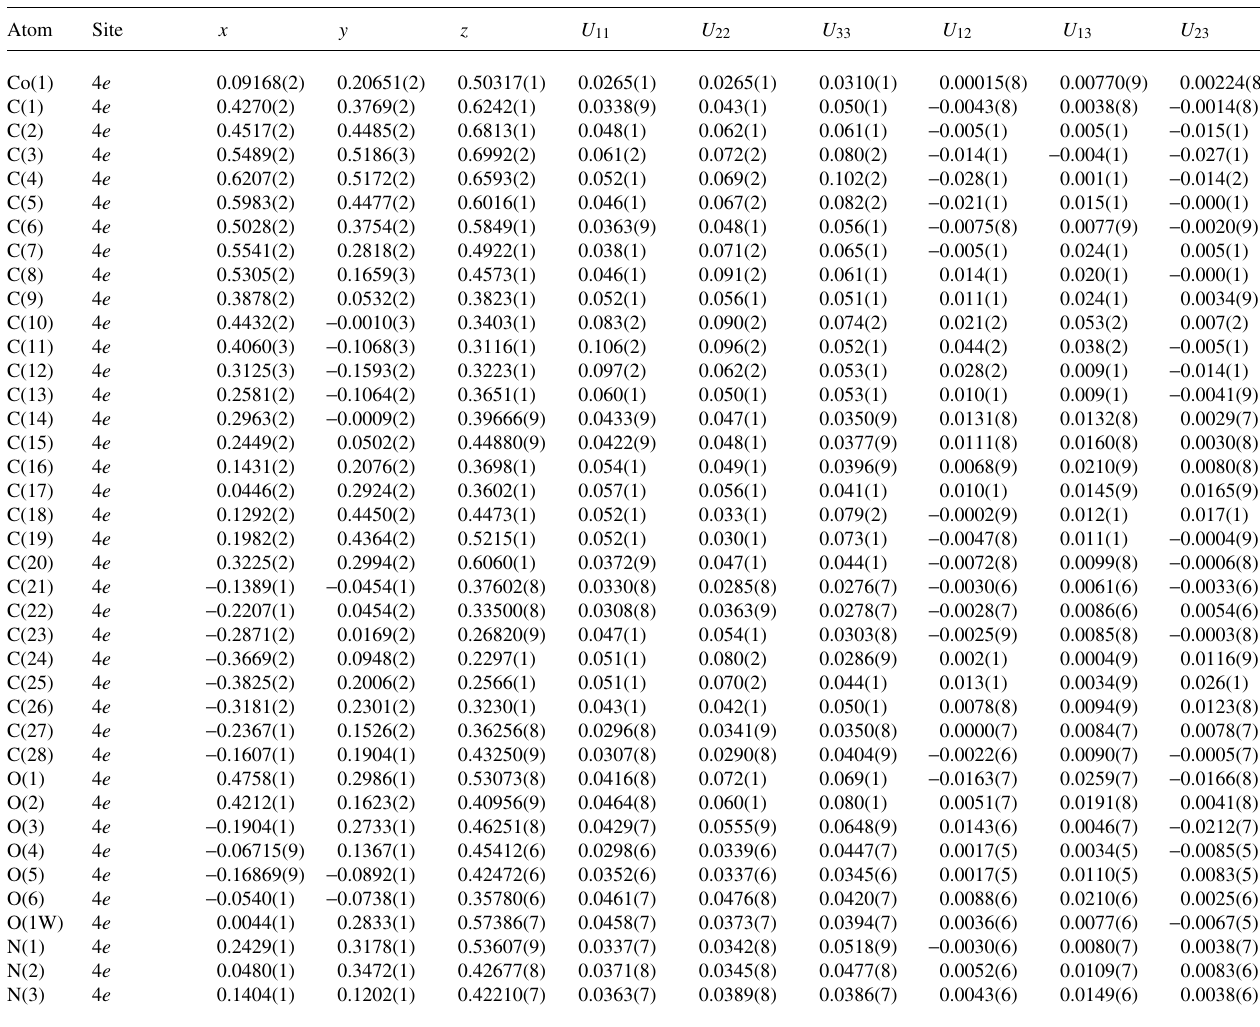
Table 3. Atomic coordinates and displacement parameters (in Å 2 )